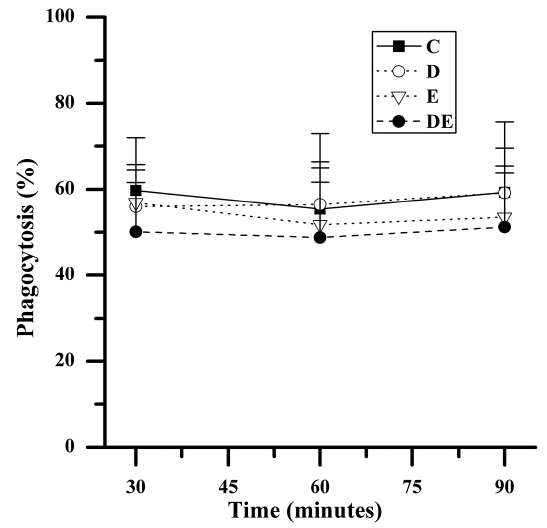
FIGURE 3 - Effect of P. edulis leaf ethanolic extract on the ability of diabetic and non-diabetic rat peritoneal macrophages to phagocyte Candida albicans . Macrophages were incubated with opsonised yeast C. albicans for 0, 30, 60, 90 or 120 minutes, and the percentage of macrophages that phagocytised one or more yeast molecules (% phagocytosis) was determined. The results represent the average ± standard deviation of 4-5 determinations per treatment. C=control group; D=diabetic animals; E= P. edulis ethanolic extract-treated non-diabetic animals; DE= P. edulis ethanolic extract-treated diabetic animals.